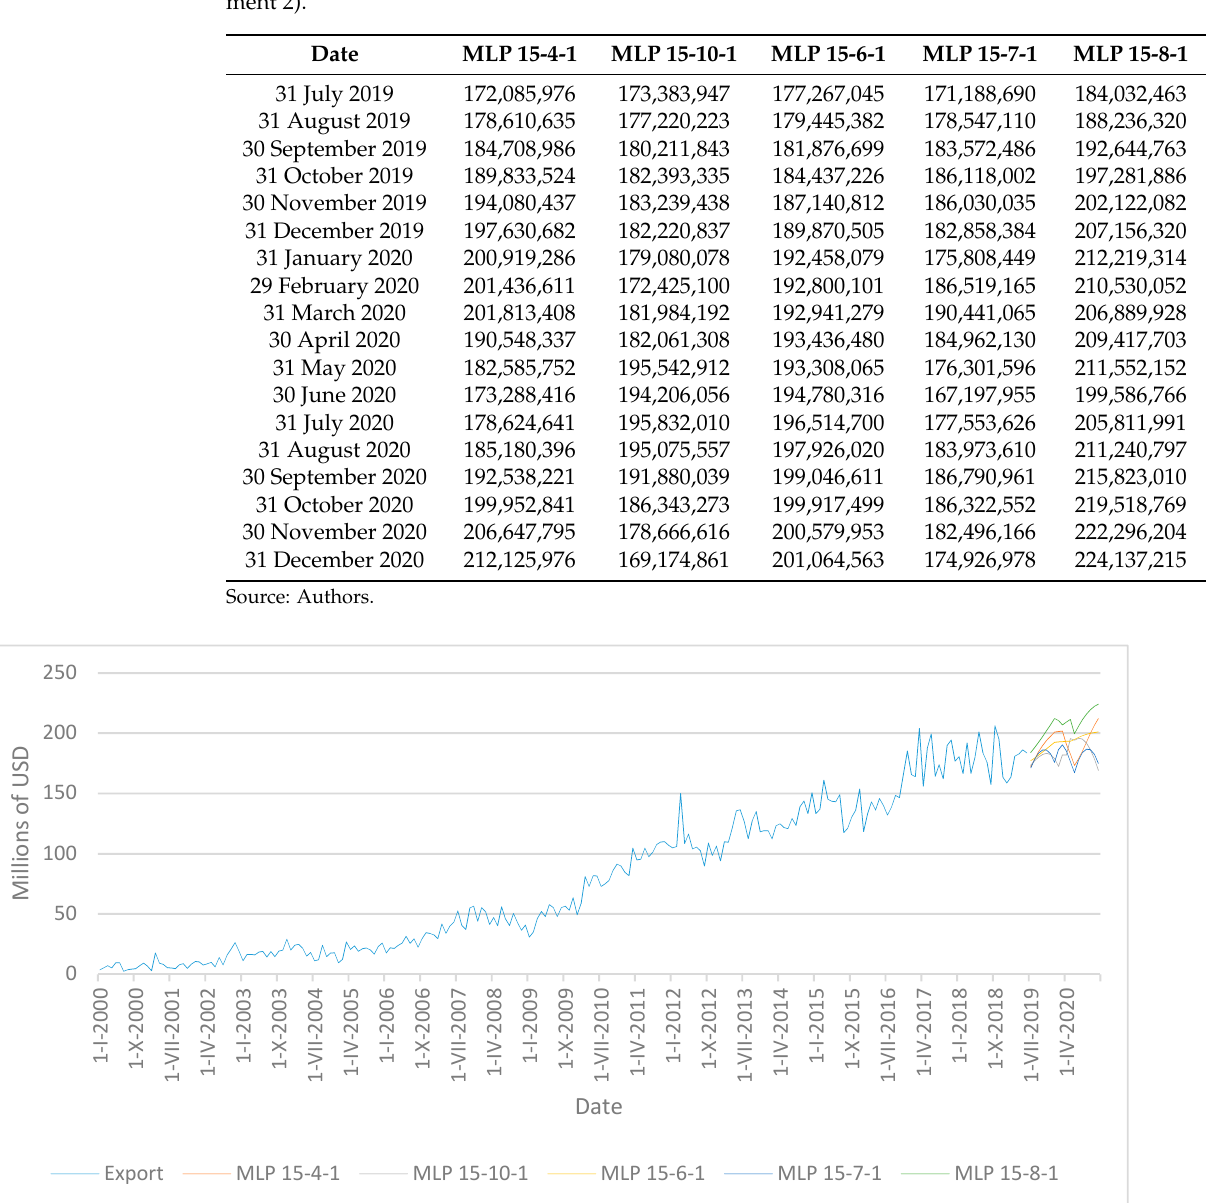
Figure 5. Time series and predicted development of exports according to retained networks (Experiment 2). Source: Au- thors.